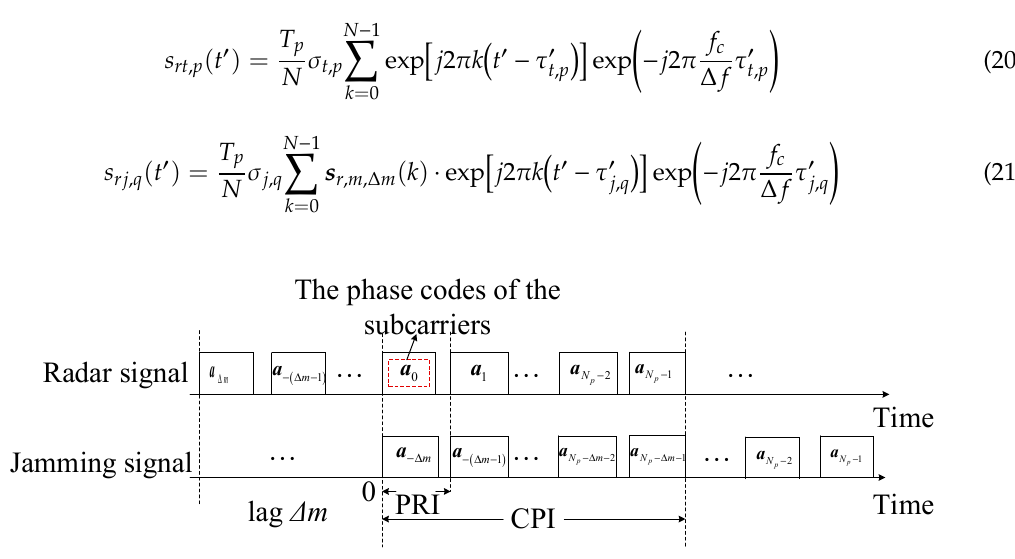
Figure 3. ECCM scheme of resisting the RDJ and JRVDJ with lag Δ m .